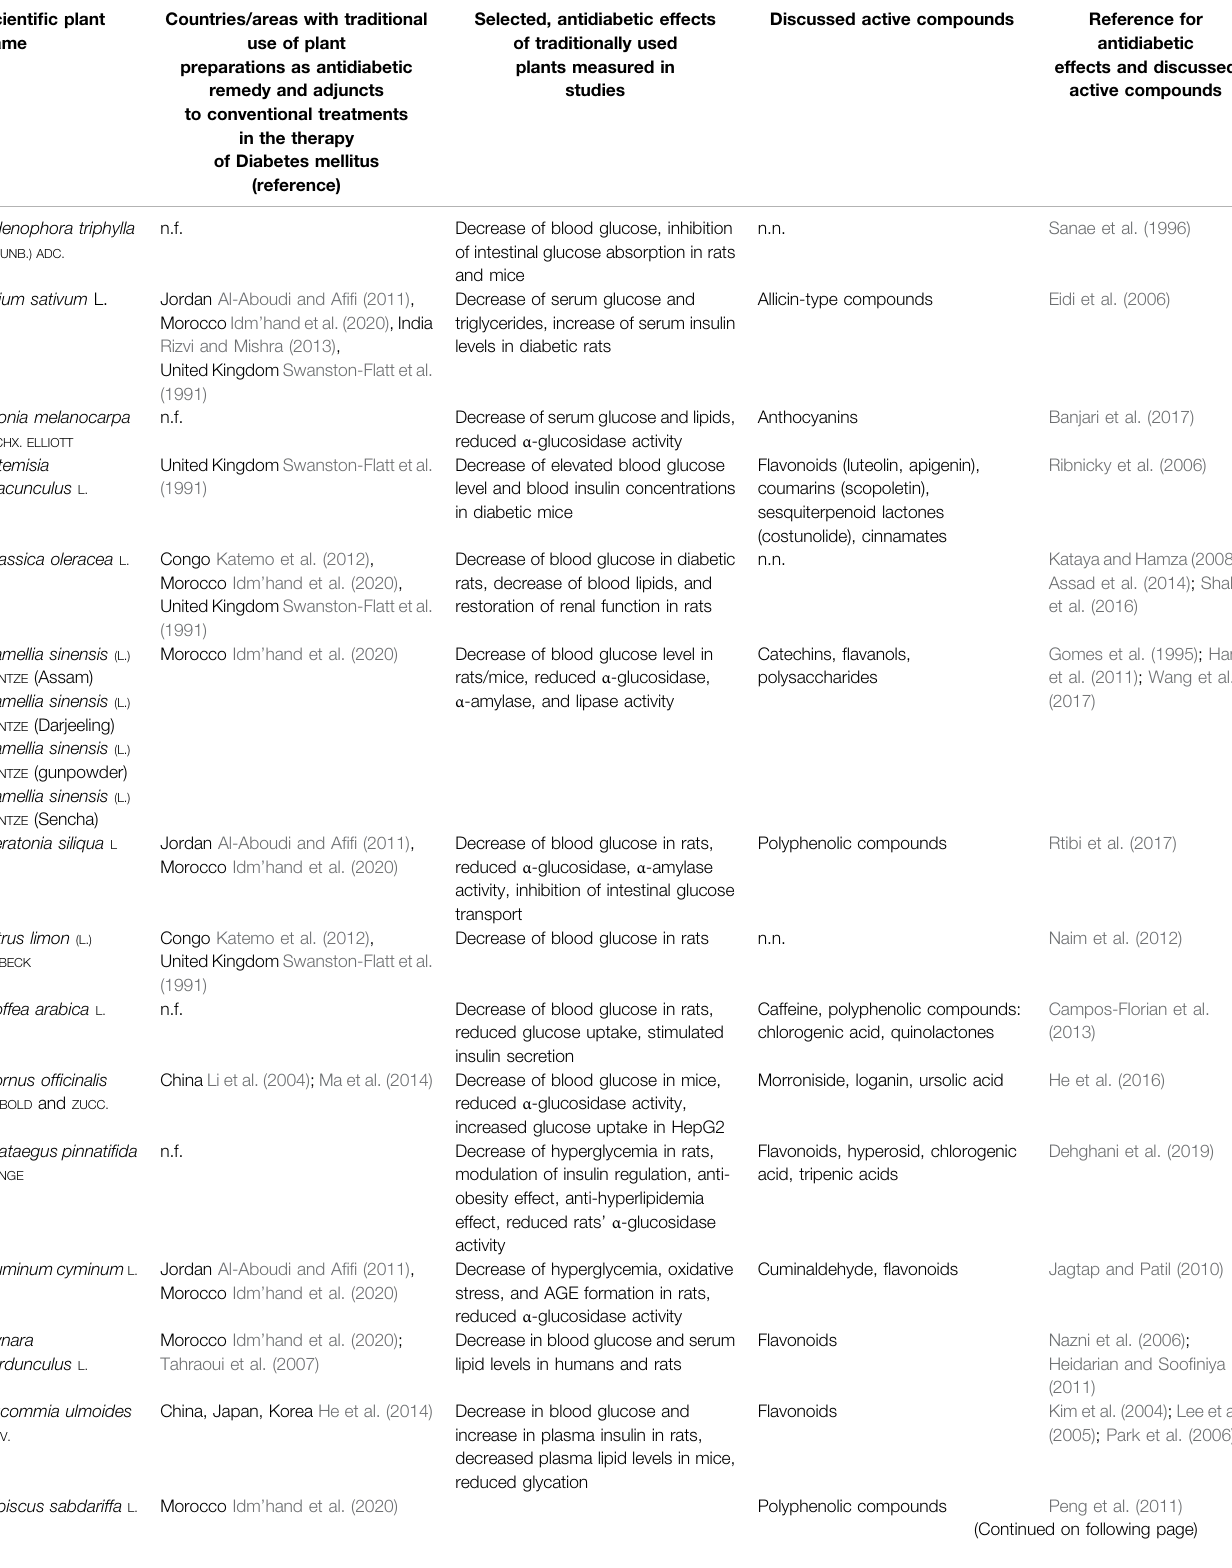
TABLE 1 | Selected plants, which are/were traditionally used in speci fi c countries and their antidiabetic effects measured in studies and discussed active compounds (n.f. (cid:1) not found in English-language literature for this indication; n.n. (cid:1) not named). Scienti fi c plant